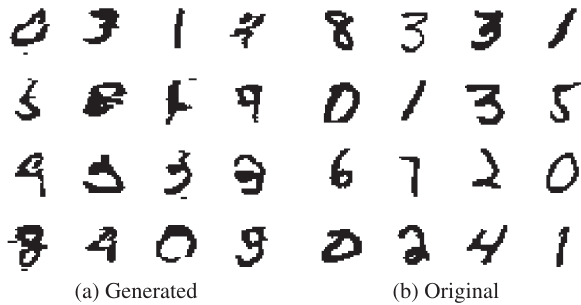
FIG. 5. (a) Images generated from the same MPS as in Fig. 4.